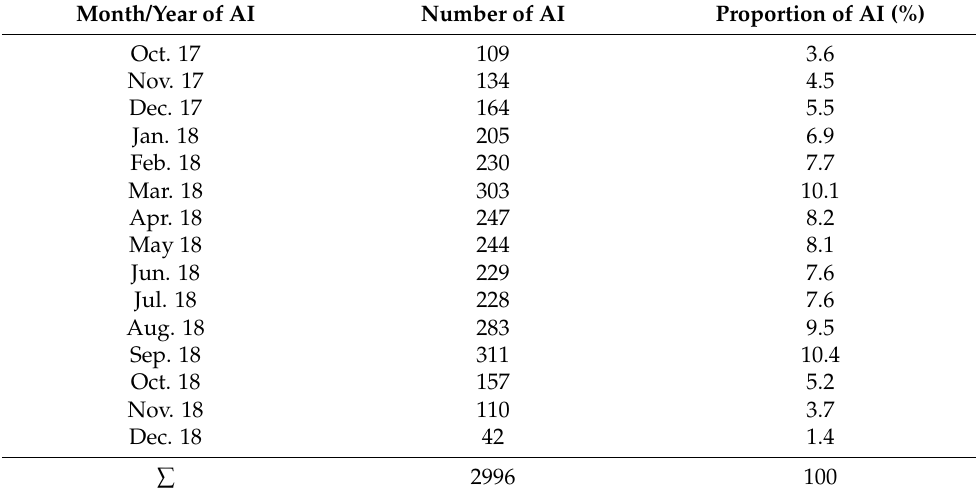
Figure 3. Conception rates of 2996 AI by month and daily ambient temperature (in °C). Table 1. Number and proportion of AI per month and year during the